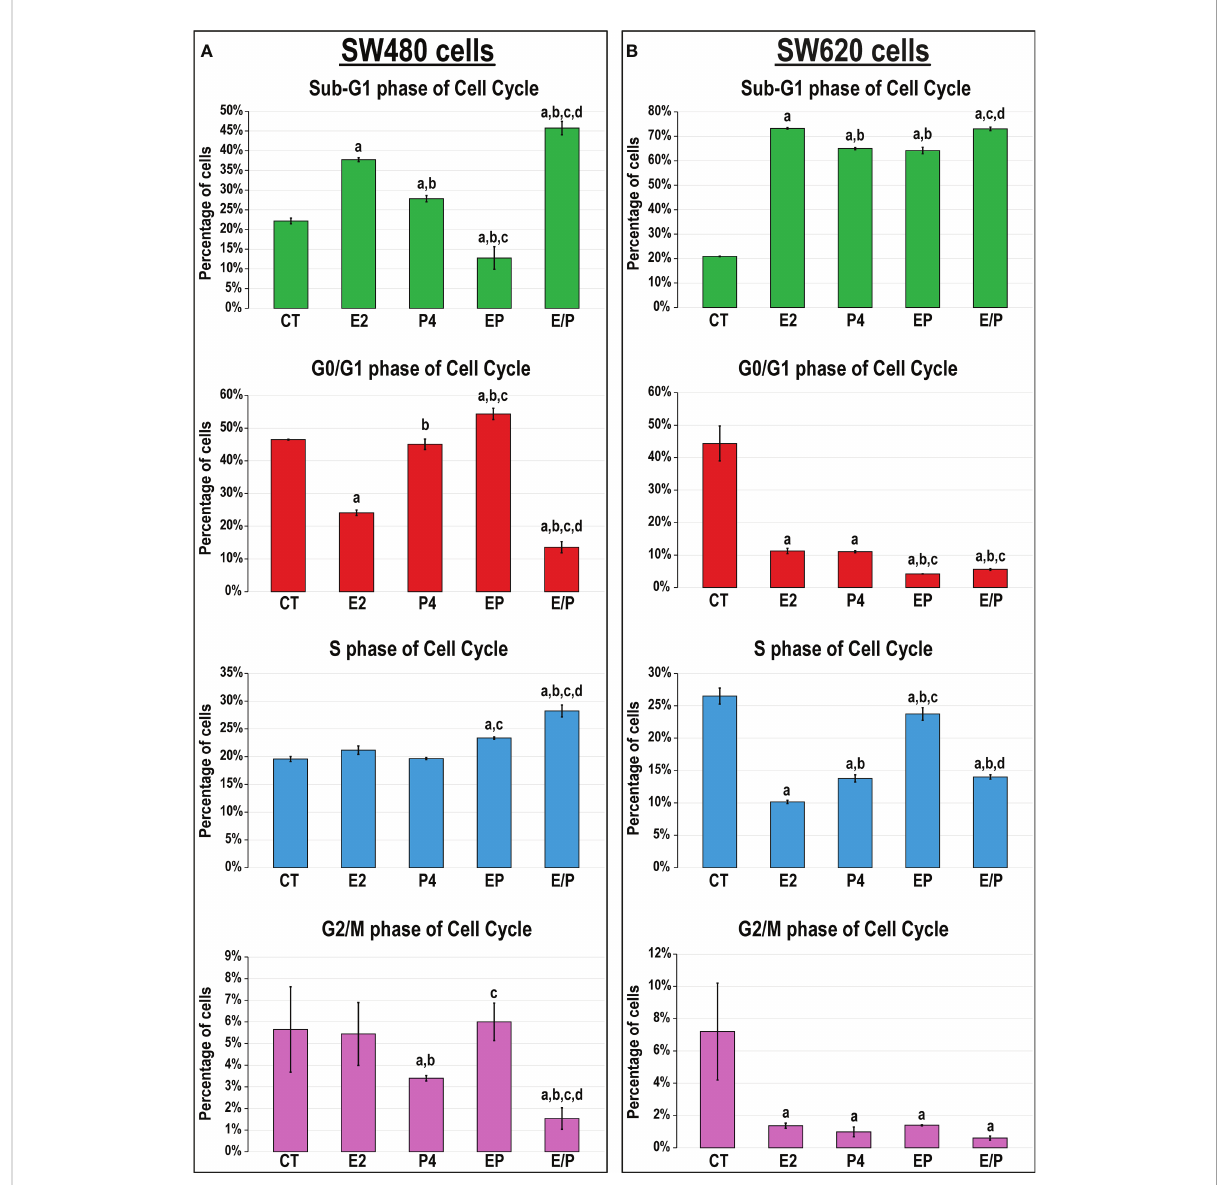
FIGURE 3 Percentages of cells (mean ± SD) in the different phases of cell cycle following the different treatment protocols with E2 and/or P4 for 48 hours in the (A) SW480 and (B) SW620 male colon cancer cell lines (mean ± SD; a P< 0.05 compared with the CT group; b P< 0.05 compared with the E2 monotherapy group; c P< 0.05 compared with P4 monotherapy and d P< 0.05 compared with EP concurrent dual therapy